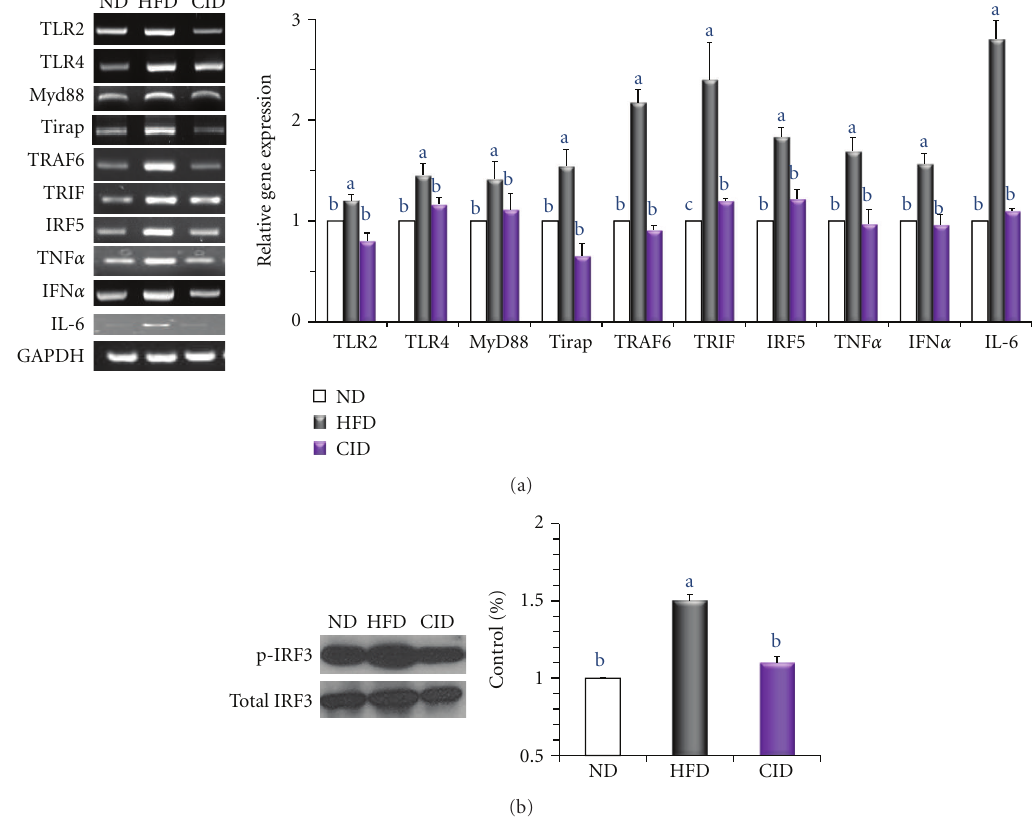
Figure 4: E ff ect of dietary cinchonine on the expression of genes involved in inflammation. Mice were fed on the ND, HFD, or CID. (a) RT-PCR analyses of TLRs-mediated proinflammatory cytokine genes. The data shown are the relative density normalized to GAPDH. (b) Protein levels of phosphorylation of IRF3 (p-IRF3) and total IRF3 in the epididymal adipose tissue of mice analyzed by Western blot. p-IRF3 was normalized to total IRF3 protein level. Bars represent the mean ± SEM, n = 8, P < 0 . 05. Di ff erent letters are statistically di ff erent.